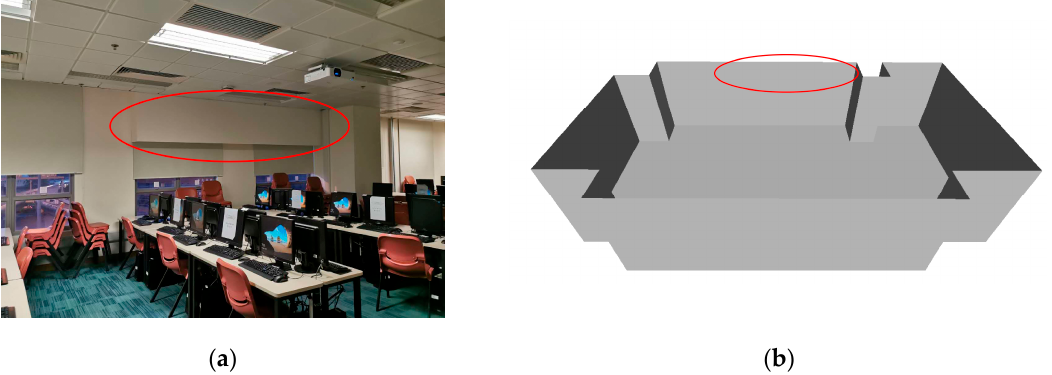
Figure 1. Example of the approach that ignores detailed structures: ( a ) photo of real indoor scenario, ( b ) the reconstructed model based on the approach of Shi et al. [21], and visualization by the opensource software MeshLab [27].